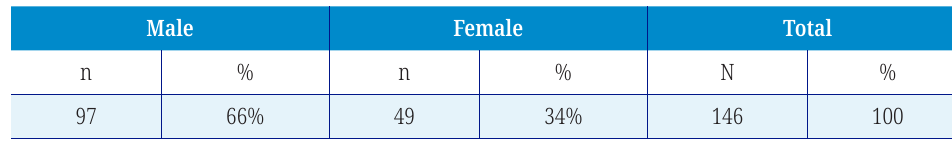
Table 1. Participant data by